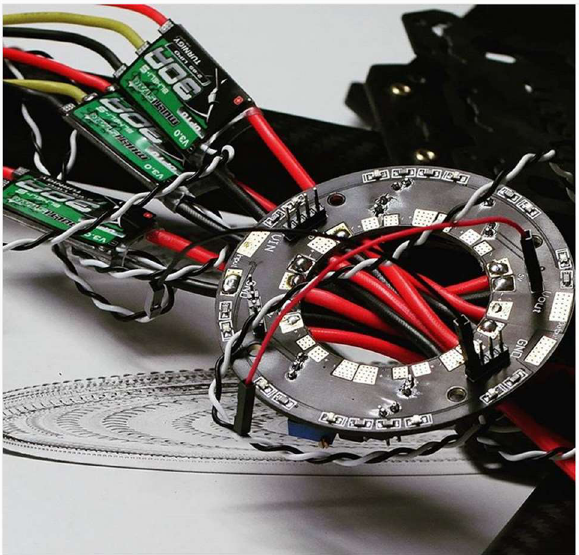
Figure 6. Power distribution board and three 30A speed